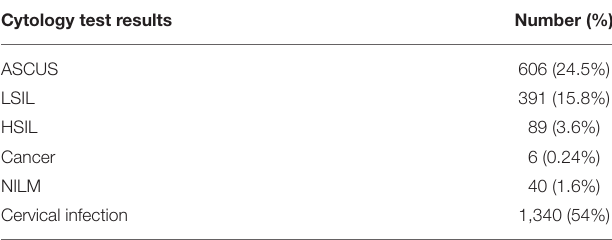
TABLE 1 | ThinPrep cytology test results in women with HPV positive ( n = 2,472).